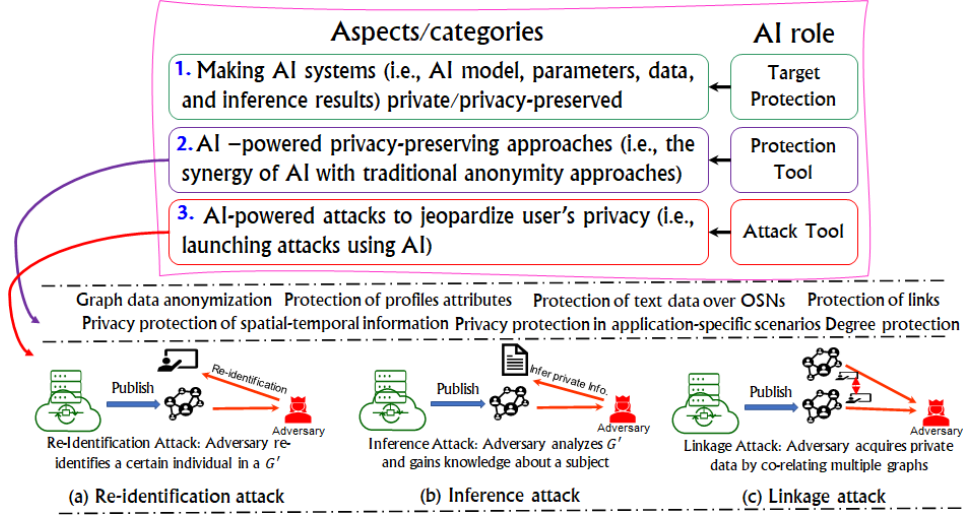
Figure 21. AI role in the privacy (or de-anonymization) of